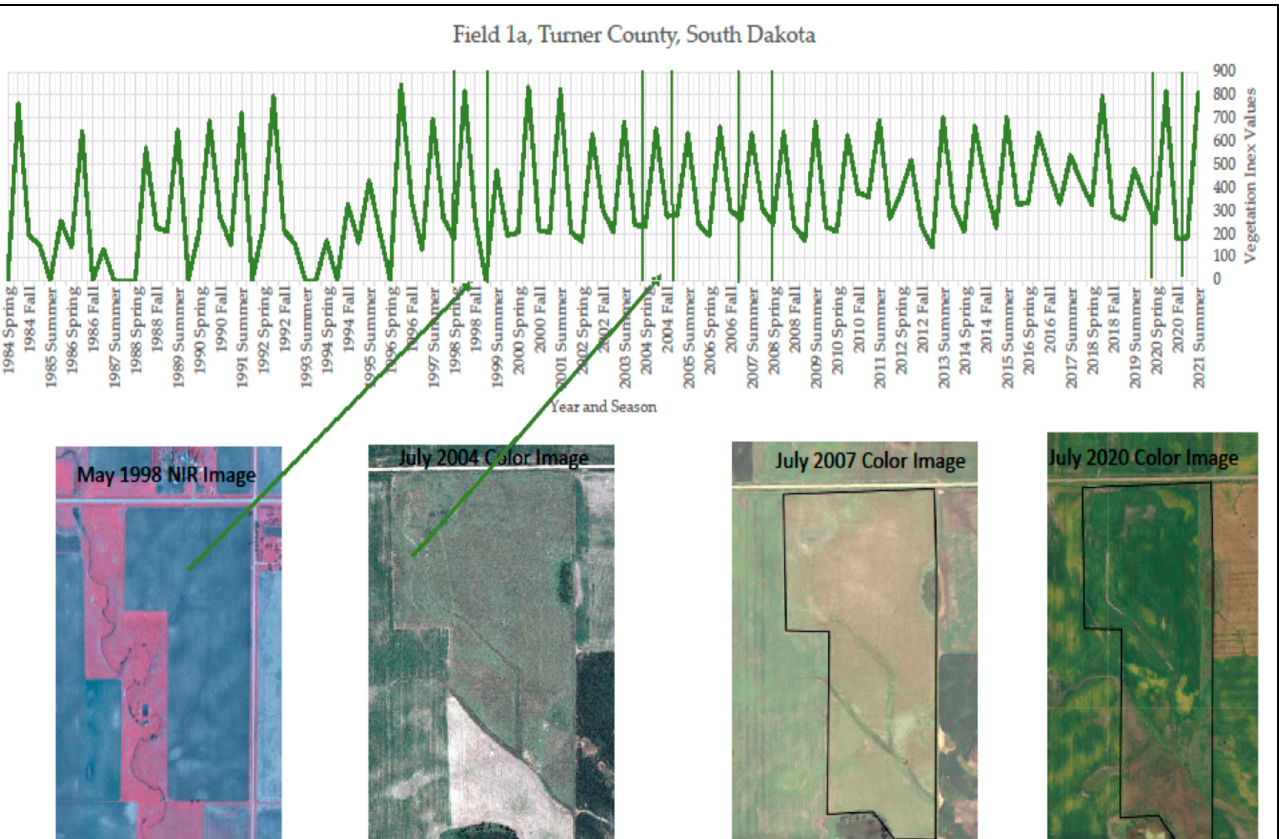
Figure 10. Example of LandTrendr temporal vegetation index signature that was crop until early 2000s, became fallow and returned to crop in 2014.